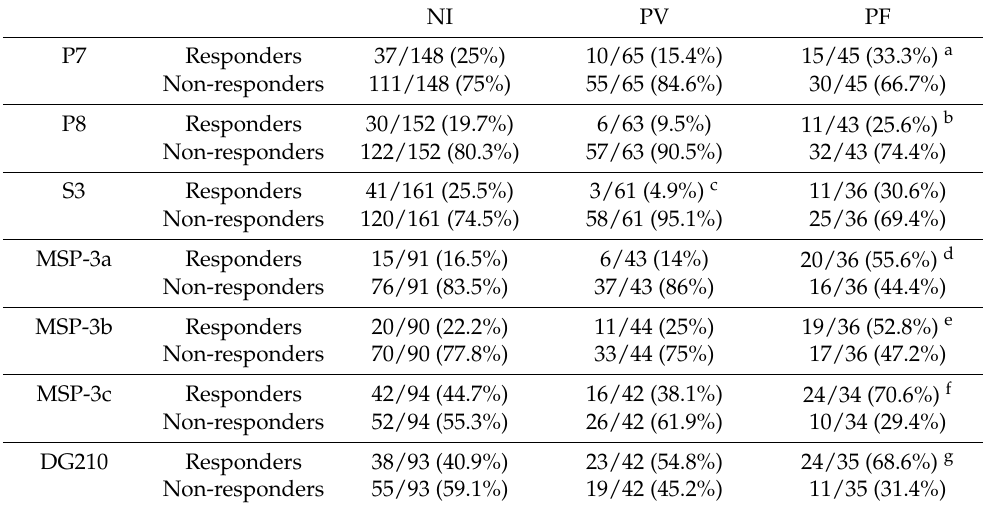
Table 2. IgG antibody response in non-infected and P. vivax- or P. falciparum -infected individuals.